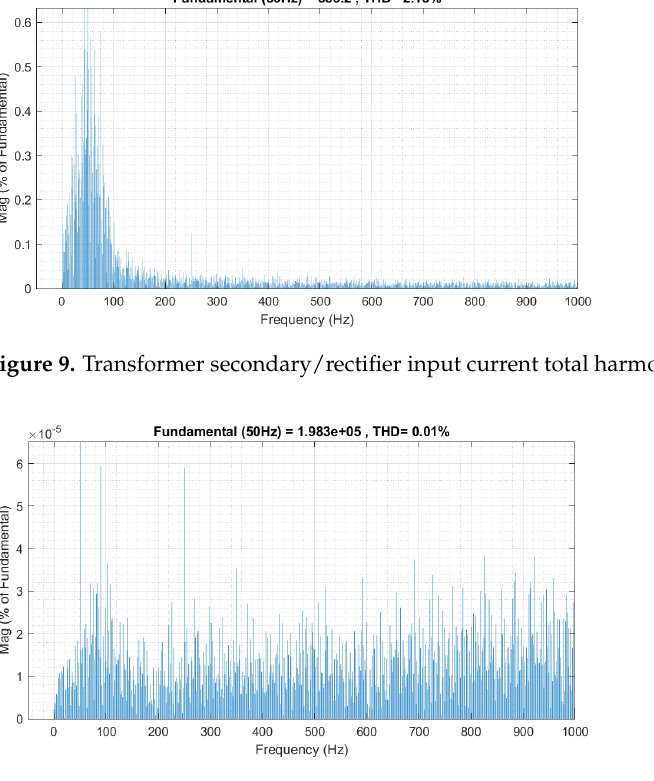
Figure 8. Transformer primary current total harmonic distortion.